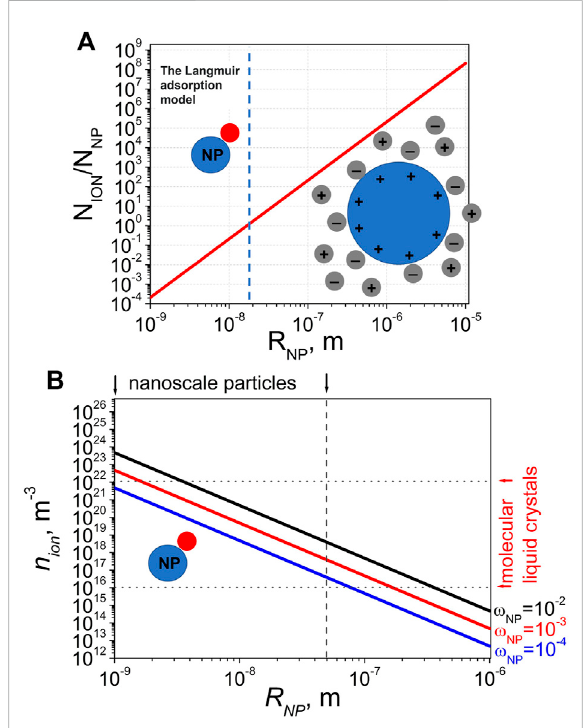
liquid crystals as a function of the particle radius. (B) The concentration of mobile ions in molecular liquid crystals as a function of the particle radius assuming a one ion per one (cid:1) 1). This concentration is colloidal particle condition ( N ION N NP computed for three values of weight concentration of nanoparticles (10 − 2 ; 10 − 3 ; 10 − 4